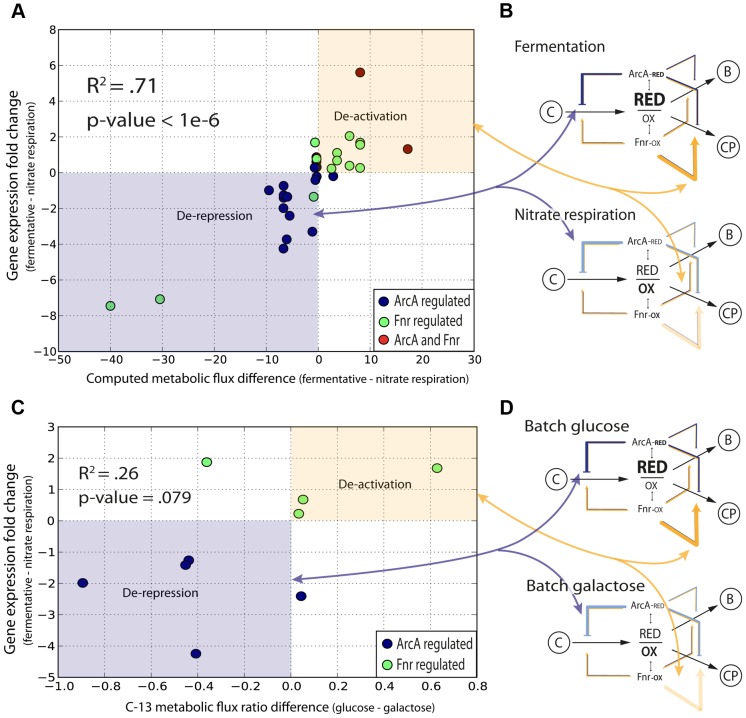
Quantitative correlation of shifts in regulatory strength between experimental conditions with shifts in flux through regulated enzymes.(A) The decrease in activity levels from anaerobic to nitrate is quantified by calculating a correlation between the change in flux for all altered reactions across nitrate and anaerobic conditions with the change in level of regulation across the same conditions. (B) Overlaying information for the specific regulators shows that ArcA is involved in the derepression of key reactions going from fermentation to nitrate respiration and Fnr is involved in deactivation. (C) The shift between glucose and galactose under batch growth mirrors the respiratory shift from fully fermentative to nitrate respiratory conditions. C-13 labeled fluxomic data generated for wild type cells under both glucose and galactose batch conditions is used to generate the same plot as in (A) and is even plotted against the same regulatory strengths between fully fermentative anaerobic cultures and nitrate respiring cultures. (D) One can again see that key ArcA regulated genes are de-repressed whereas Fnr regulated genes are de-activated.